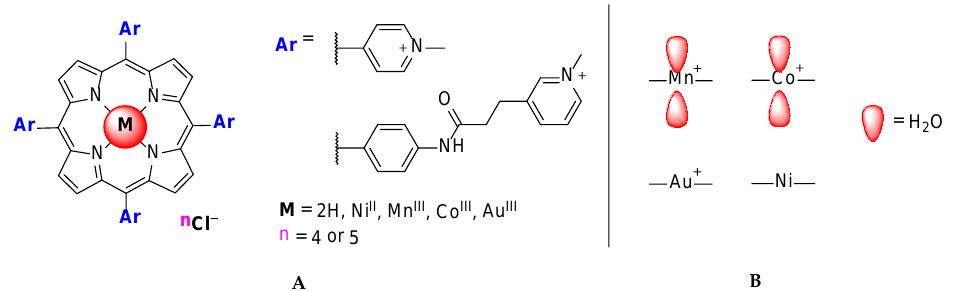
Figure 11. Structure of H 2 TMPyP and analogs with bulky substituents ( A ); presence or absence of axial substituents in different metal ions ( B ) studied by Romera et al. [60]. The presence of water molecules on either side of the porphyrin core of Mn III TMPyP and Co III TMPyP (Figure 11B) was pointed out as a factor that prevents the porphyrin intercalation between the base pairs of DNA and, consequently, decreases the porphyrins binding affinity to double-stranded DNA. On the other hand, the authors revealed that axial water molecules might hinder the initial stacking of the porphyrin molecule at the G-quadruplex end. The in vitro cellular tests performed with free-base and Mn III TMPyP analogs containing bulky substituents showed that these ligands can penetrate cells and mediate some of the typical cellular effects of small GQ ligands. A porphyrin scaffold, the 5,10,15,20-tetrakis(4-(1-methylpyridinium-2-yl)phenyl)- were studied, aiming to evaluate the impact of the variation of the charge position and axial coordination in the center of the porphyrin in the binding affinity of the selected complexes. The MTMPy 2 PP derivatives were studied in the presence of GQ and duplex DNA structures using fluorescence resonance energy transfer (FRET), CD, SPR and NMR methods [73]. The authors conclude that the interaction with GQ of all the derivatives, even of the Co III complex coordinated with two water molecules, occurs by a π -stacking-like mode with an external G-quartet. Later, Dejeu et al. [74] extended the previous study to the Ni II , Co III and Mn III complexes of the 5,10,15,20-tetrakis(4-guanidinophenyl)porphyrin (MTGP) (Figure 12).